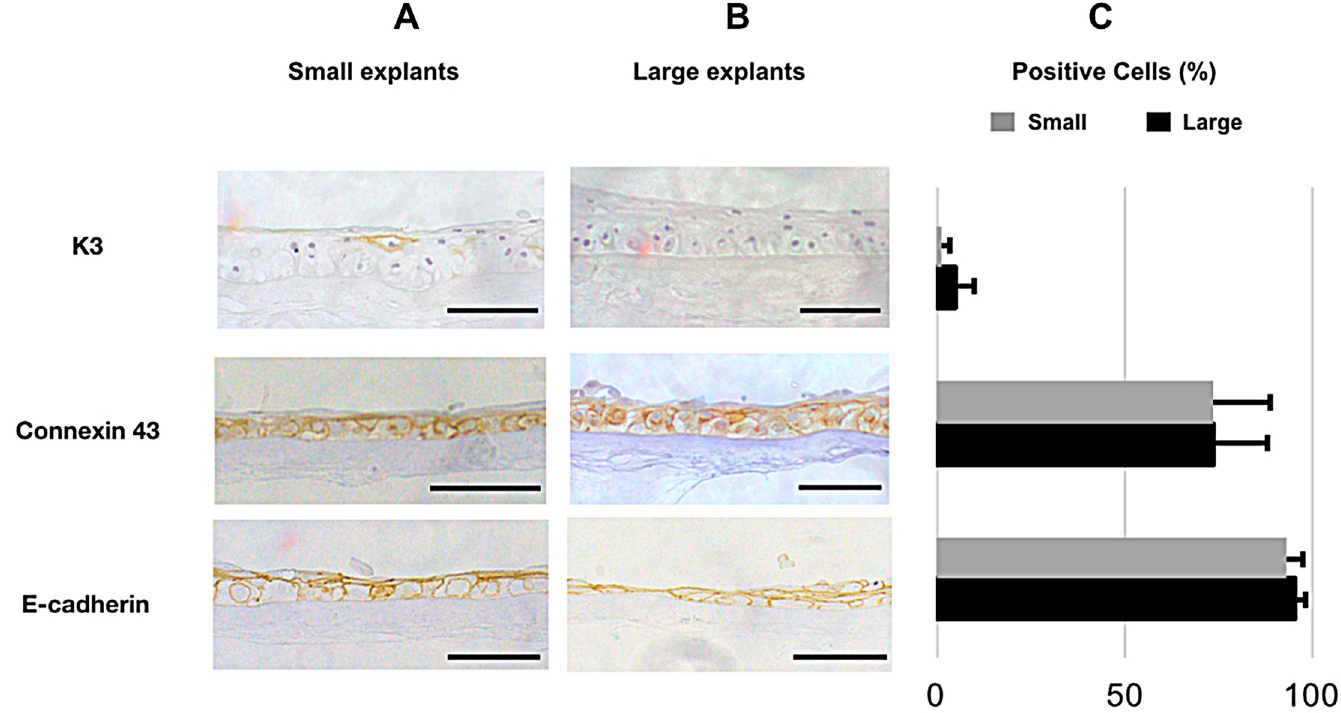
Fig 8. Immunostaining (A and B) and Quantification (C) of differentiation markers. A, and B: Immunostaining of 1) K3, 2) Connexin 43, and 3) E-cadherin of cultured human LEC derived from small (A) and large (B) limbal explants. The selected areas in the micrographs are representative for the staining and not for the epithelial thickness in the study groups. Scale bar = 100 μ m. C: Bar charts showing the percentage of positive cells for the differentiation markers in cultured LEC sheets cells derived from small (grey) and large (black) explants. Error bars represent the standard deviation of mean values.